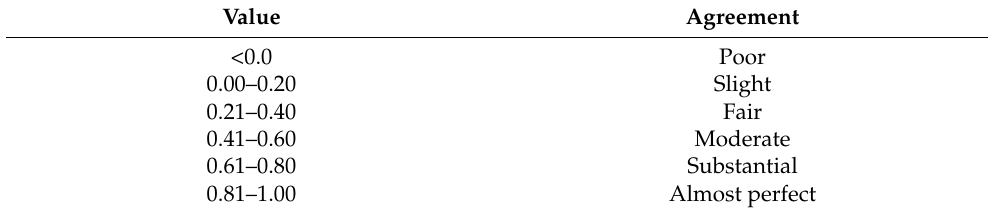
Table 1. Interrater agreement